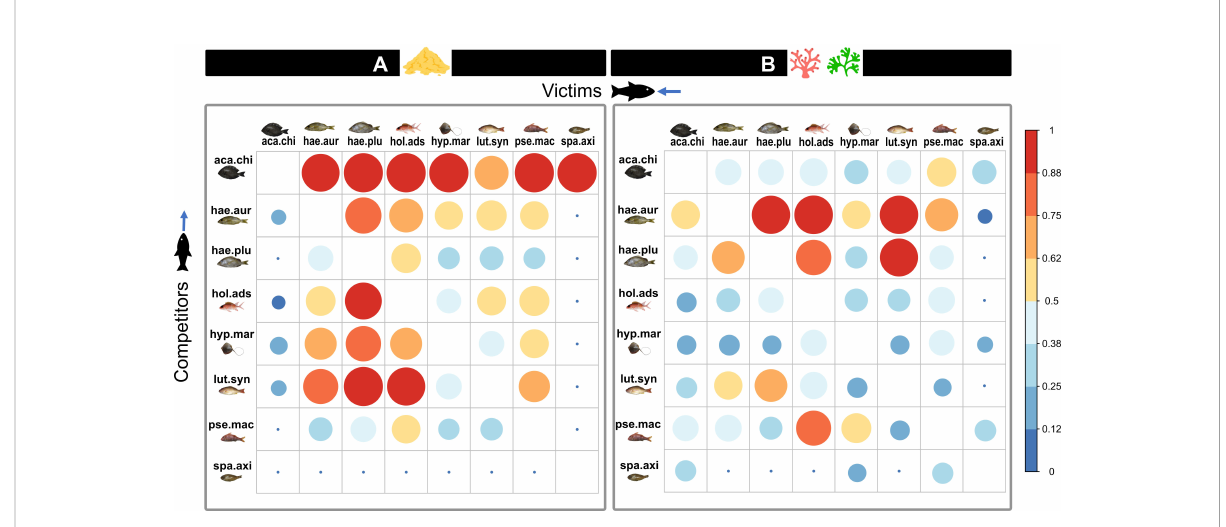
FIGURE 6 Matrix representing the intensity of the interspeci fi c competition between each species pair in zones (A) (sand-dominated) and (B) (complex substrates). The colour and the size represent the proportion of the victim ’ s niche (column) overlapped by the competitor (row). lut.syn, Lutjanus synagris ; pse.mac, Pseudopenneus maculatus ; hae.plu, Haemulon plumierii; hae.aur, Haemulon aurolineatum ; hyp.mar, Hypanus marianae ; hol.ads, Holocentrus adscencionis ; aca.chi, Acanthurus chirurgus ; spa.axi, Sparisoma axillare